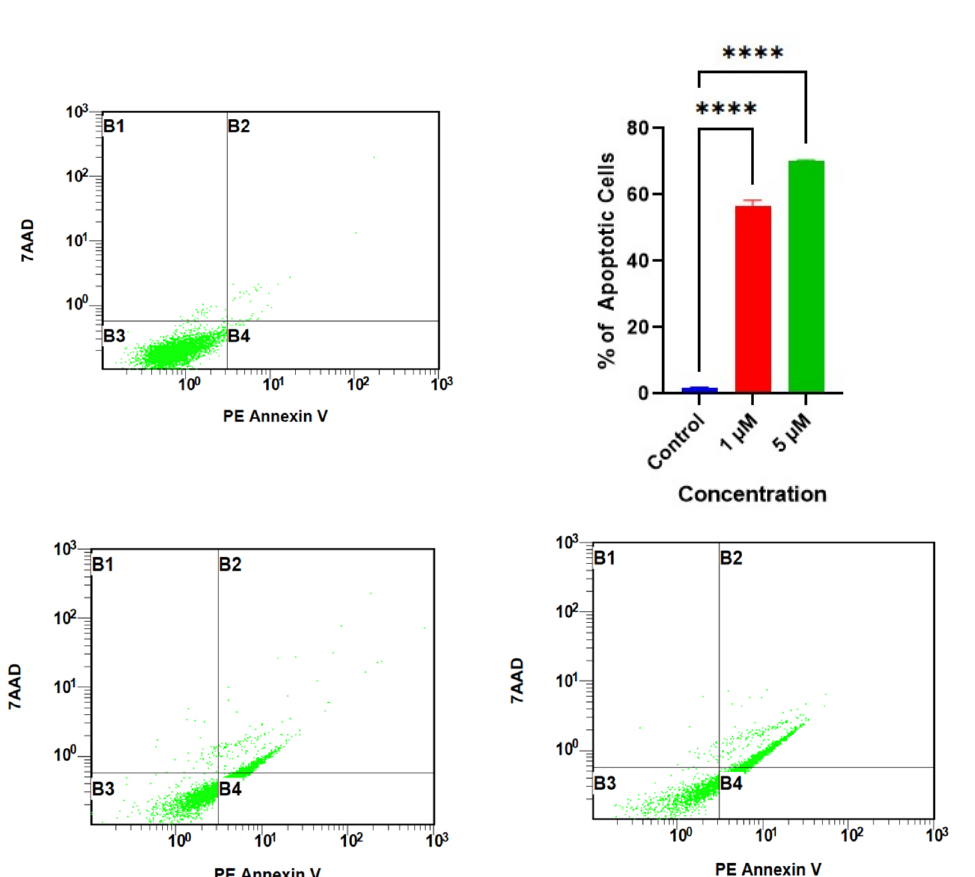
Figure 5. Apoptotic evaluation by Annexin V staining of MCF-7 cells treated with 2 . The (****) is significant compare to control.